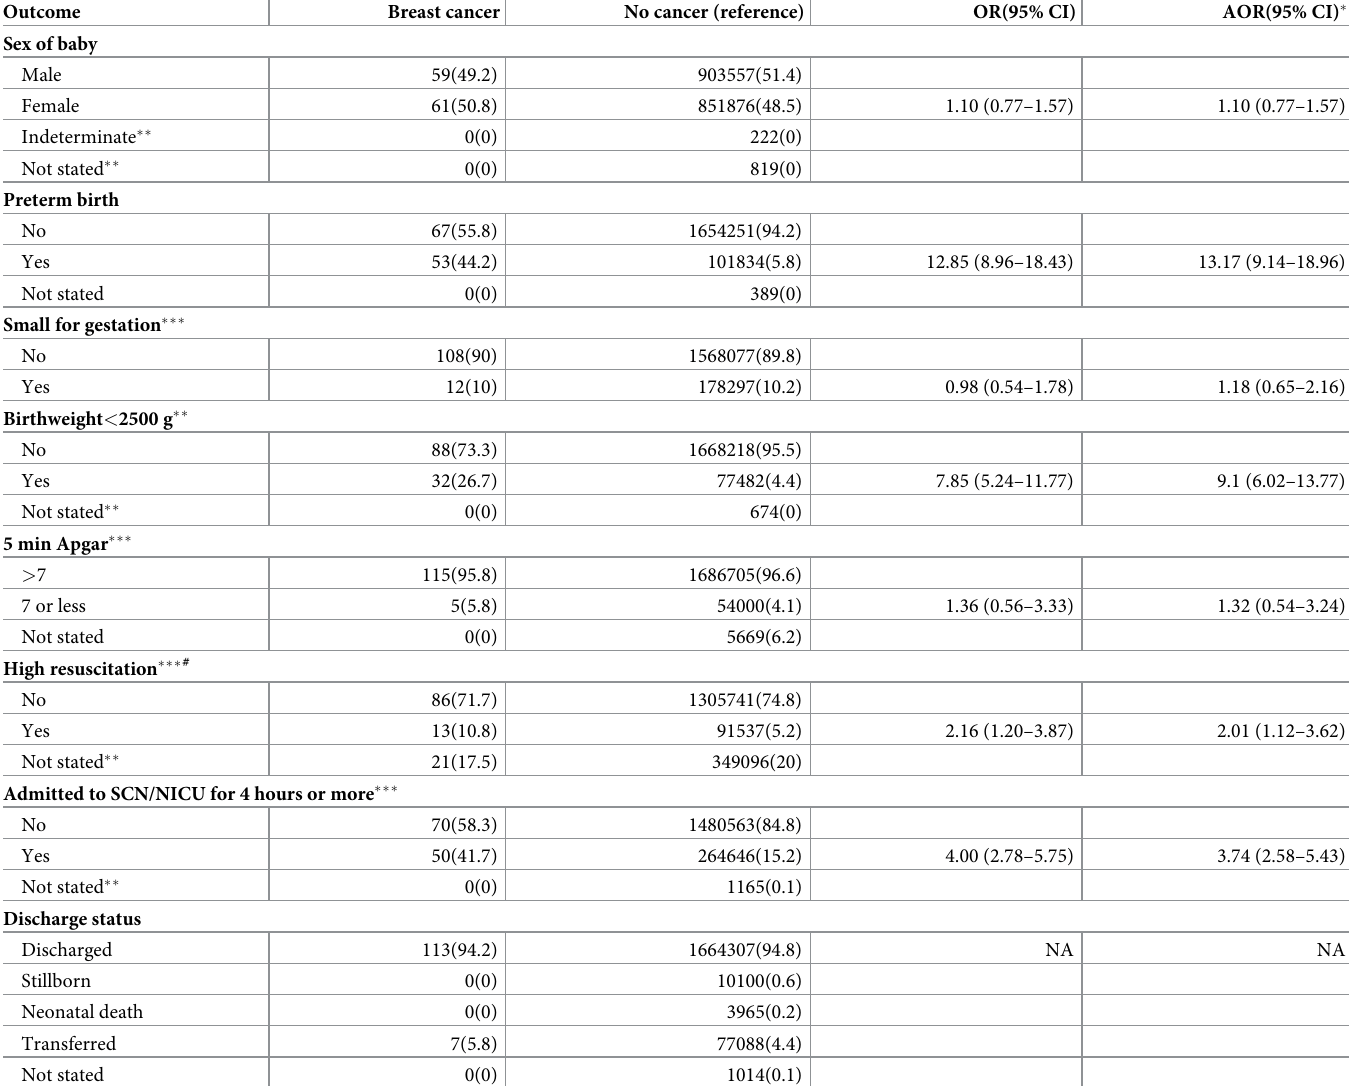
Table 3. Neonatal outcomes for singleton babies by maternal cancer